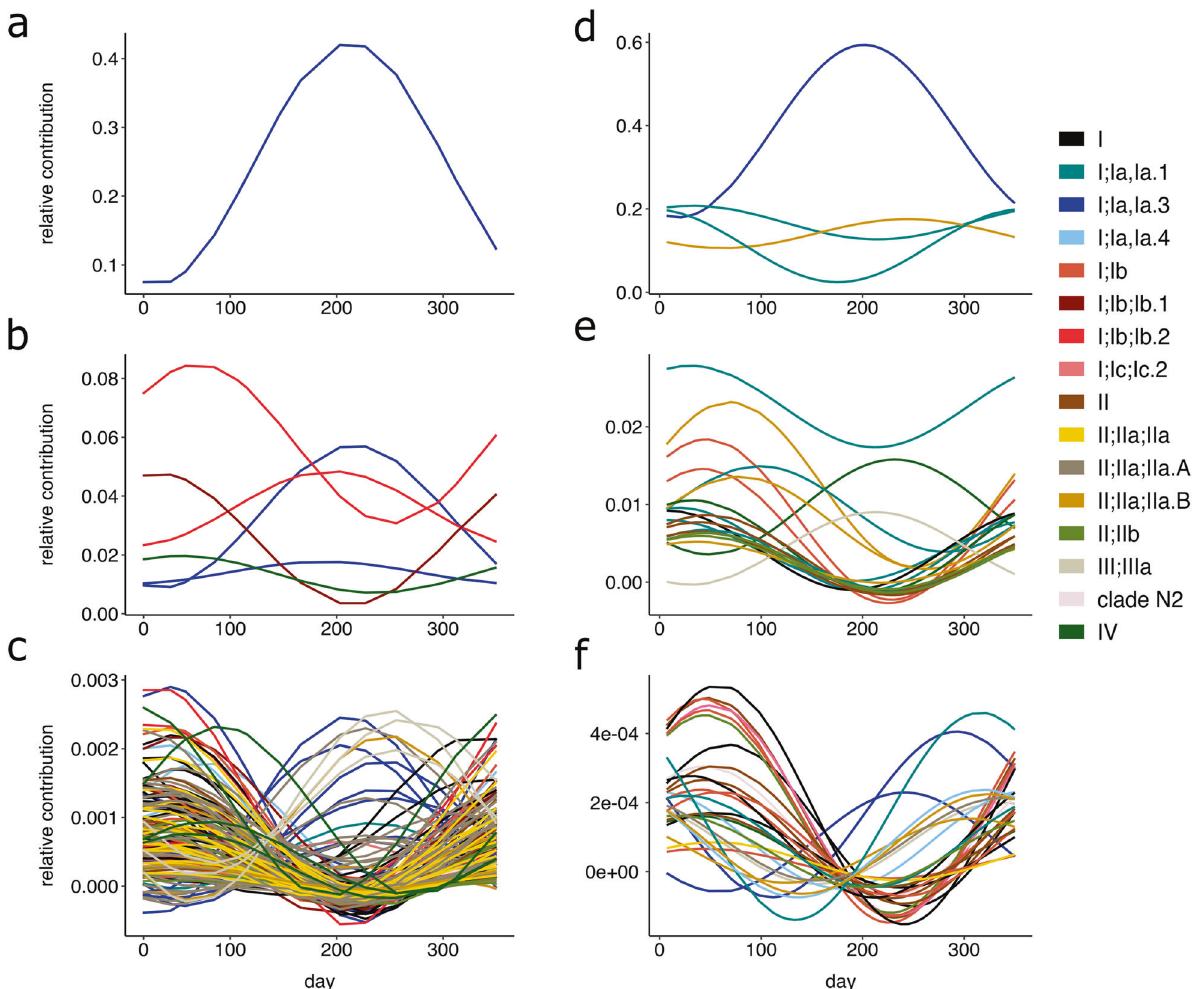
Fig. 5 Annual abundance trends of SAR11 ASVs in the Bermuda Atlantic Time-Series and the Western English Channel. A harmonic linear regression model was used to determine signi fi cant seasonal trends ( p < 0.05) of individual ASVs. Two main patterns of ASVs with seasonal contributions peaking in winter and summer were identi fi ed. The Bermuda Atlantic Time-Series ASVs are shown in a – c . a ASVs with a total relative contribution greater than 5%, b ASVs with a total relative contribution between 0.5 and 5% and c ASVs with a total relative contribution less than 0.5%. The Western English Channel ASVs are shown in d – f . d ASVs with a total relative contribution greater than 10%, e ASVs with a total relative contribution between 0.5 and 10% and f ASVs with a total relative contribution less than 0.5%. ASV-adjusted model curves are color-coded by ecotype. Day 0 corresponds to the 1st of